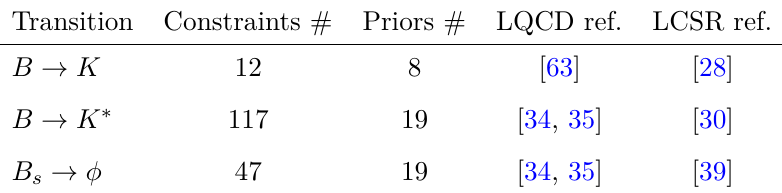
Table 2 . Details of the fit of the local B → M FFs. The number of constraints is the total number of synthetic data points from LQCD and LCSR analyses. The number of (uniform) priors is the number of independent α F k